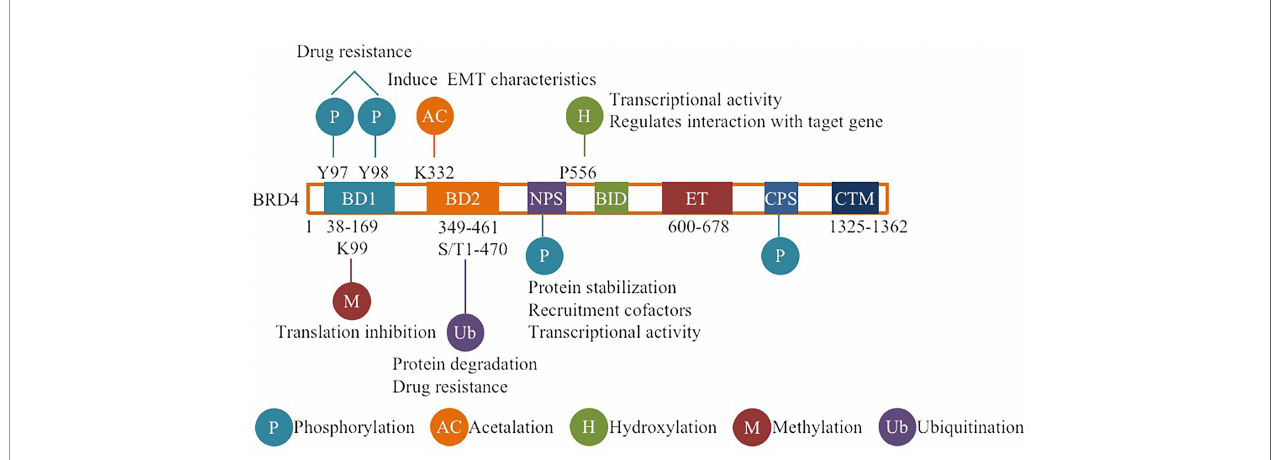
FIGURE 1 | Overview of BRD4 PTMs: The major sites for BRD4 modi fi cations (phosphorylation, ubiquitination, acetylation, methylation, hydroxylation) are plotted. Different colors are used to differentiate distinct modi fi cation types. The representative functions of some modi fi cations are pointed